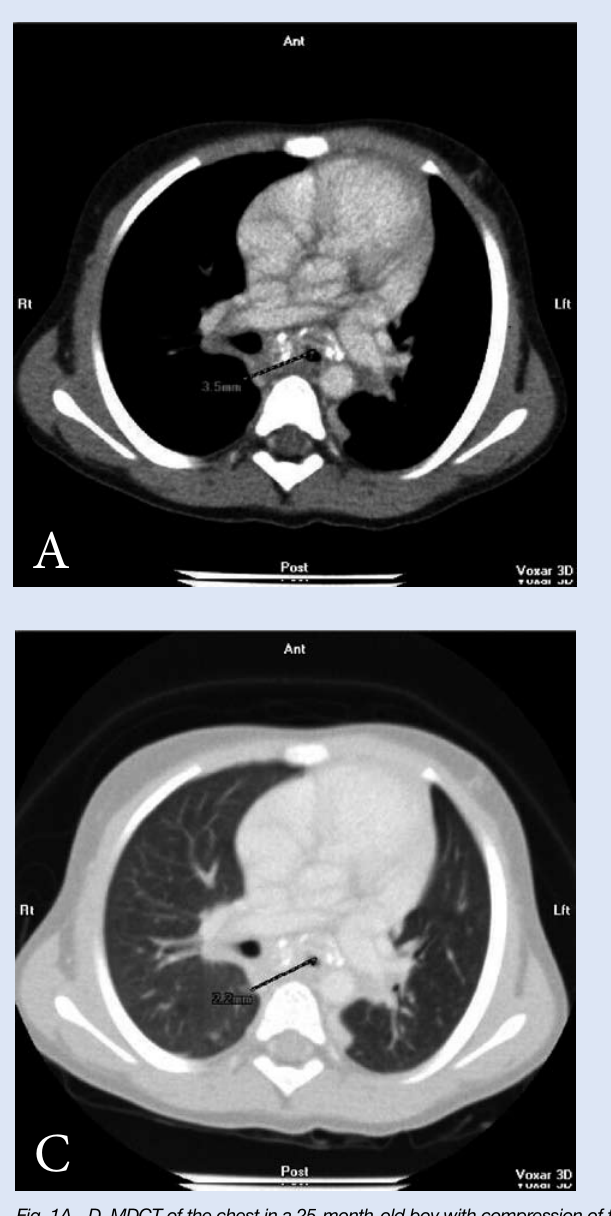
Table I indicates the differences between axial measurements and those after MPR in the longitudinal axis for all the airways: of the differences, 56.4% were <0.5 mm, 35.5% were 0.5 - 1.0 mm, and 8.1% were >1 mm.